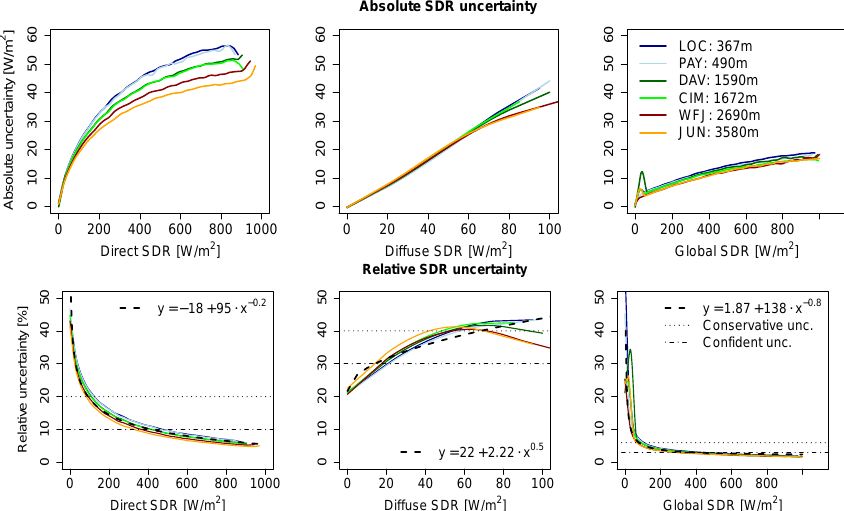
Fig. 6. Uncertainty expressed as smoothed mean lengths of the standard deviation of clear-sky direct, diffuse and global SDR, as a function of radiation [Wm − 2 ]. The graphs were obtained by estimating the mean standard deviation of each 5Wm − 2 radiation interval. Smoothing was performed using non-parametric regression. The dashed black line denotes the fit of the function f ( SDR ) = σ SDR,rel , where x : = SDR i and y : = σ SDR . The coefficients of the function f (x) = y were obtained by non-linear least-squares i , rel